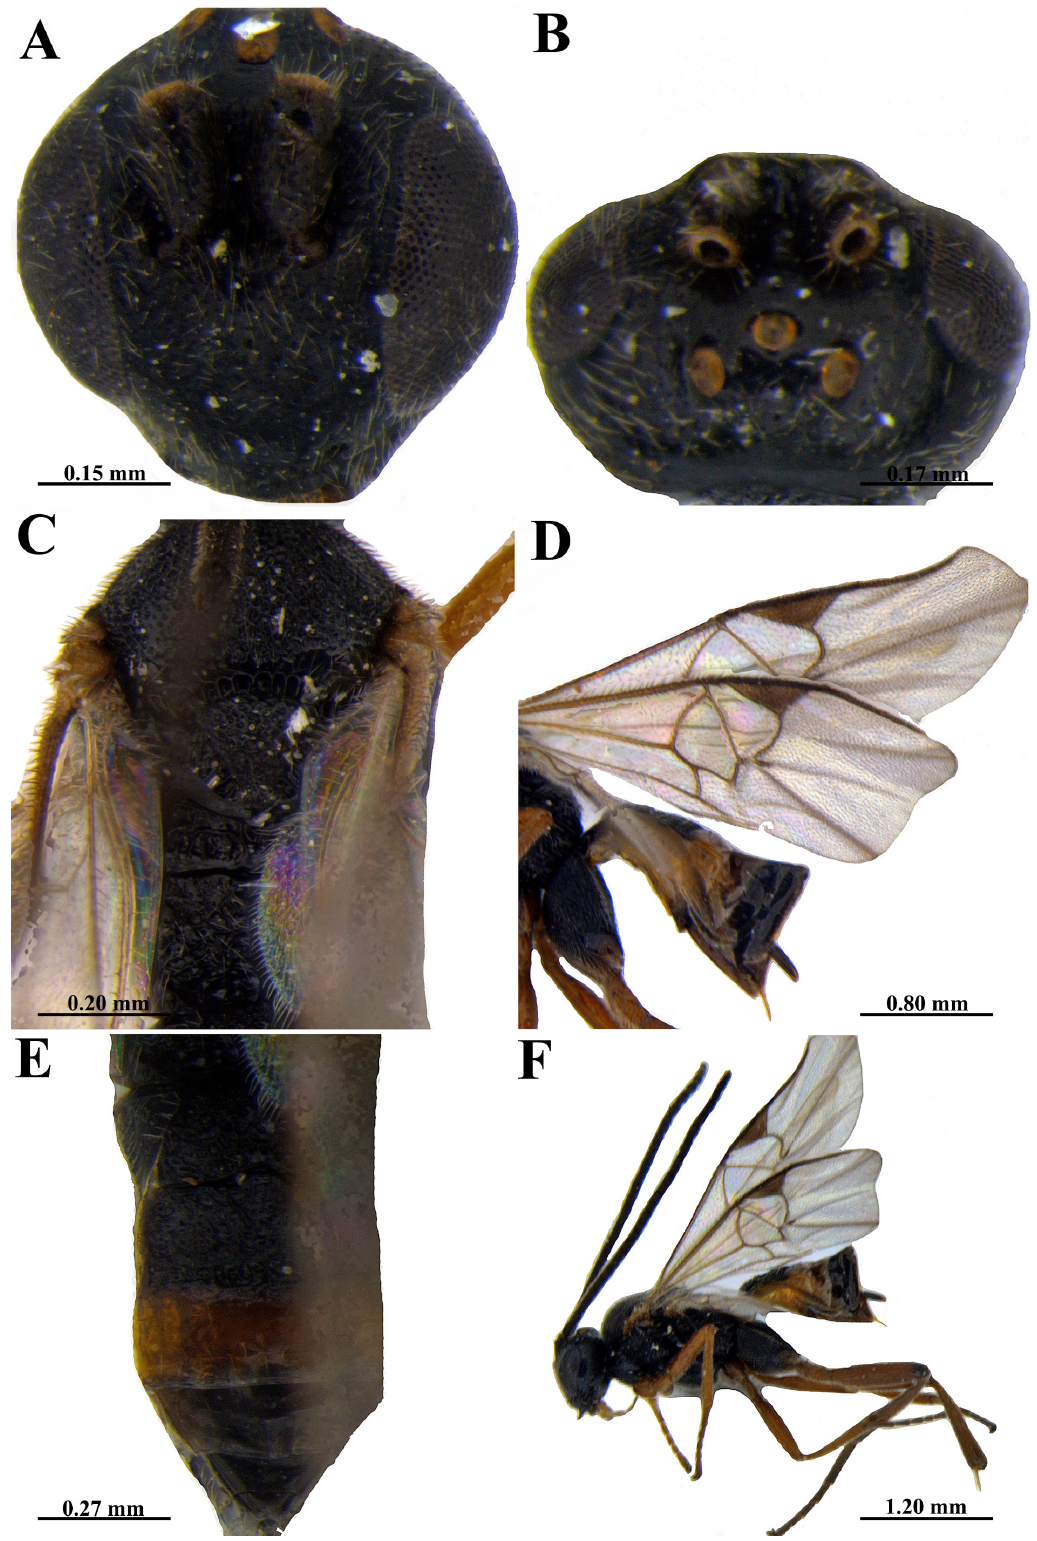
Fig. 4. Cotesia cynthiae (Nixon, 1974). A . Head, frontal view., ICAR-NBAIR/NIM/MICROG/ COT/3416. B . Head, dorsal view. C . Mesosoma, dorsal view. D . Fore wing. E . Metasoma, dorsal view. F . Habitus, lateral